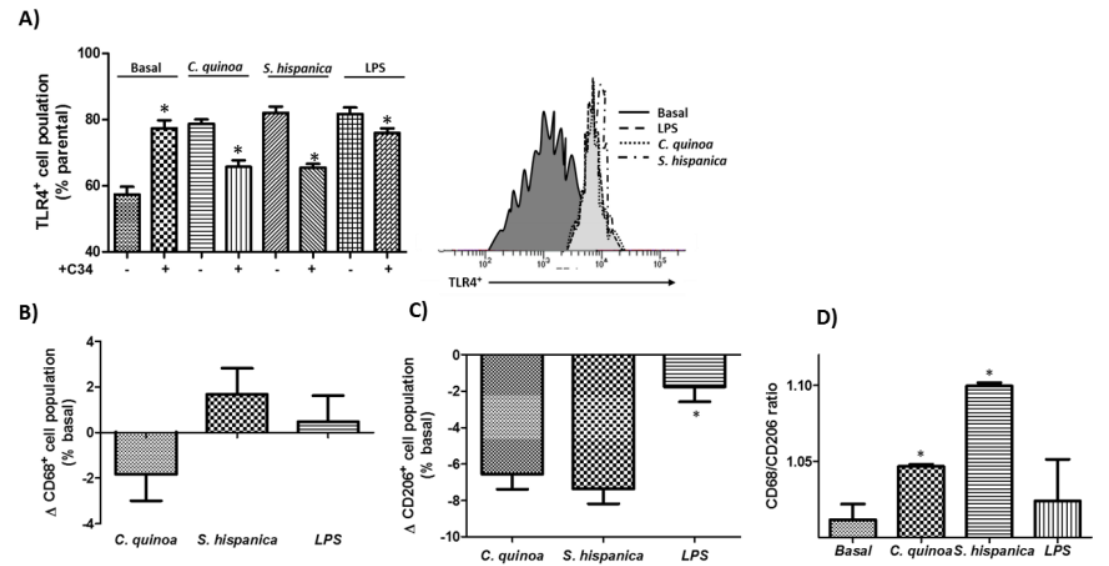
Figure 2. Identification of Toll-like receptor (TLR)-4 agonists. FACS analysis of TLR4 expression ( A ) and immunephenotyping of the macrophage population ( B , C ) challenged to protease inhibitors from C. quinoa or S. hispanica L. and lipopolysaccharide (10 ng / mL). ( D ) Variations of the CD68 / CD206 ratio in HB8902 cultures. The results are expressed as mean ± standard deviation (n = 4). * Indicates statistical differences in relation to their counterparts.